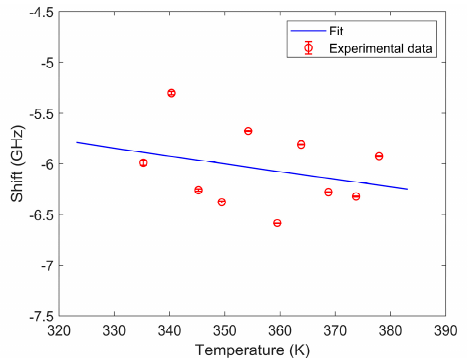
Table 2. The fits to the measured line widths and frequency shifts of N 2 , as a function of temperature.